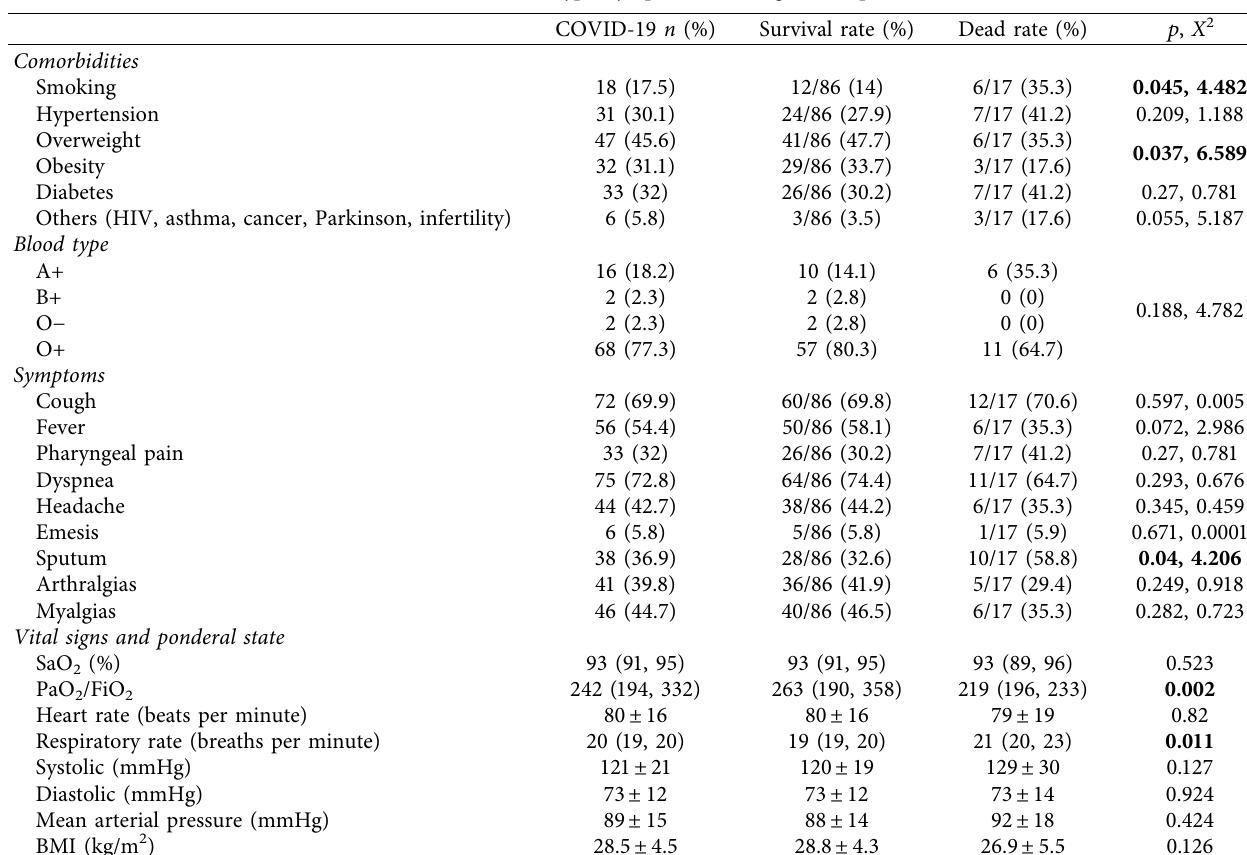
Table 2: Comorbidities, blood type, symptoms, vital signs, and ponderal state.